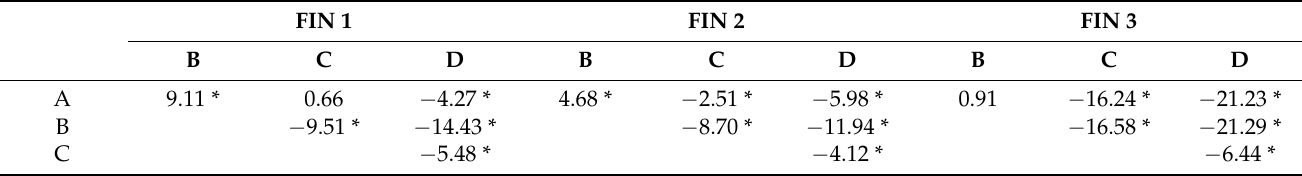
Table 6. Correlations between forest development levels and willingness to finance them (U Mann– Whitney test for pairs of forests). Table 7. Preference for each forest type in relation to respondents’